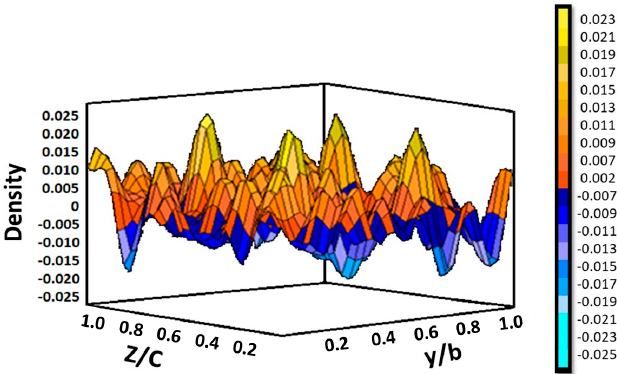
Figure 2. Localization by difference Fourier analysis of the interstitial oxygen atoms (O3) at 8 c (x,y,z) sites, corresponding to the x = 0.22 layer, for La 1.2 Sr 0.6 Ba 0.2 InO 4+ δ from neutron powder diffraction (NPD) data at room temperature.